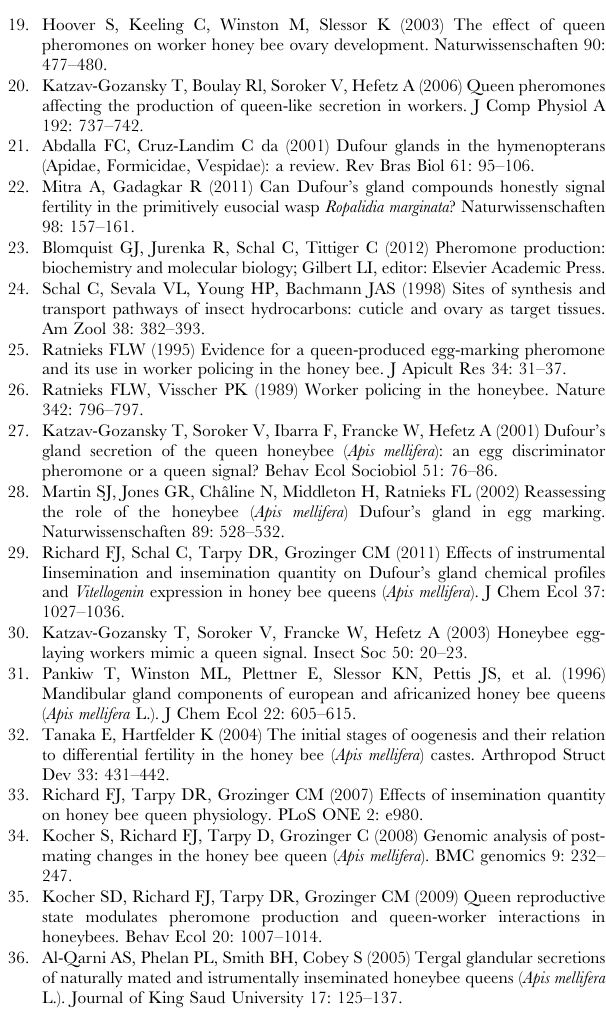
exposed to CO 2 and CO 2 + physical manipulation (fragmentation patterns are shown for one of the CO 2 queens). Figure S2 Fragmentation patterns of individual com- pounds in experiment 2. Shown here are the compounds recorded from the mandibular gland extracts of the queens instrumentally inseminated with low or high volume of either saline or semen (fragmentation patterns are shown for one of the SA1 queens). Table S1 Quantities of individual hydrocarbons and esters found in the Dufour’s glands of the queens exposed to CO 2 and CO 2 + physical manipulation. (XLSX) Table S2 Quantities of individual hydrocarbons and esters found in the Dufour’s glands of the queens instrumentally inseminated with low or high volume of either saline or semen. Table S3 Information for the ten most abundant ions (m/z and intensities) for each of the unknown com- pounds found in the mandibular gland extracts of the